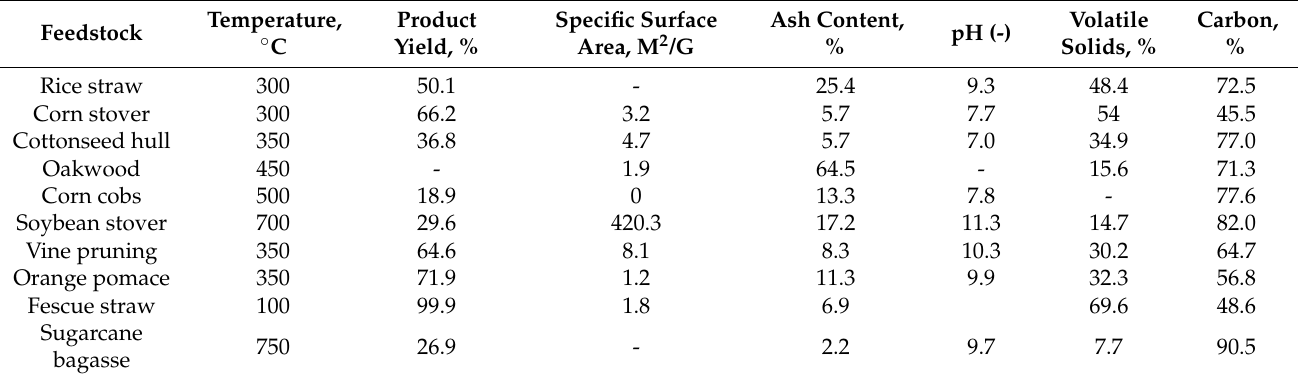
Figure 5. The potential applications of pyrolysis-based bio-oils adapted from [55] with modifications. The biochar characteristics at different temperatures and selected feedstock types are presented in Table 7 [37–42]. The feedstock type, pyrolysis temperature, and production conditions have a role to play towards these (physicochemical) properties. Table 7. Biochar characteristics at different temperatures and feedstock types